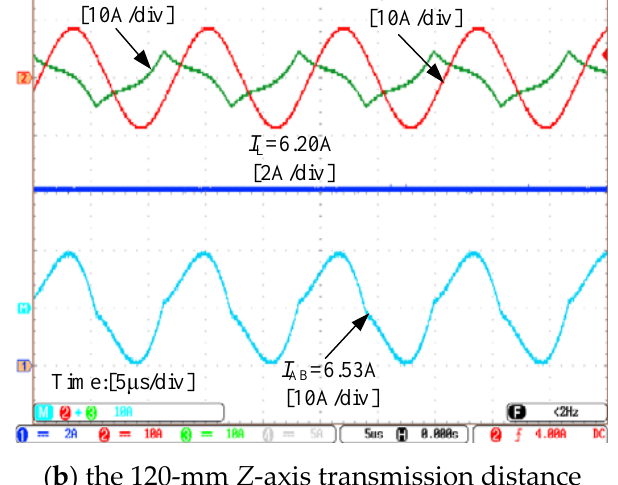
3 and I 7 with R L = 17